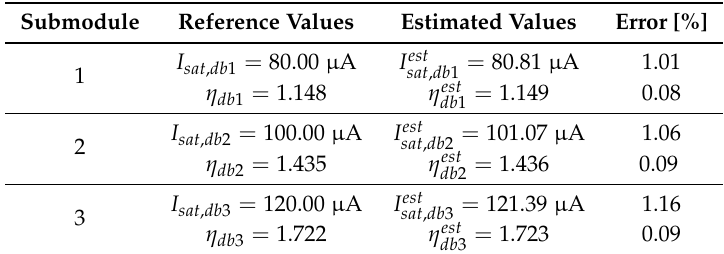
Table 2. Relative errors for the estimated parameters under simulation escenario 1.